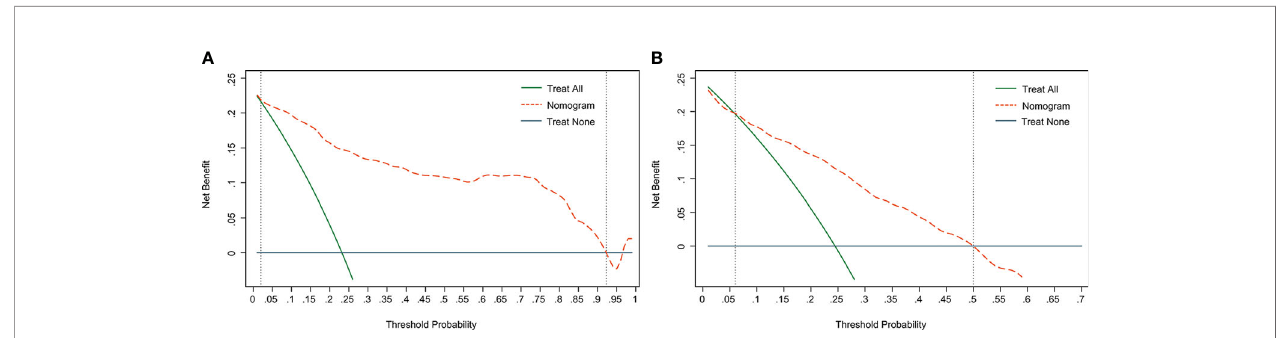
FIGURE 5 | Decision curve analysis (DCA) of the nomogram. (A) The DCA curve of the training cohort; (B) The DCA curve of the validation cohort. The orange line shows the nomogram. The green line represents the assumption that all patients have undergone SLNB. The dark blue line represents the assumption that no patients have undergone SLNB. The decision curve revealed that it was more bene fi t to use the nomogram in our study to predict SLN metastasis than the treat-all-patients scheme or the treat-none scheme, when the threshold probability of a patient is 2%-92%, and 6%-50% in the training cohort and validation cohort,